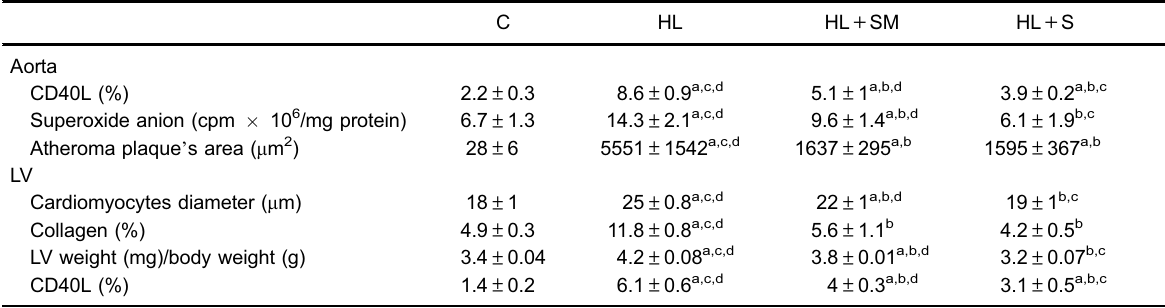
Figure 1. Representative photomicrographs of aortic section with immunohistochemical peroxidase staining to CD40L (A – D) and aortic atherosclerotic plaques (E – H). Representative photomicrographs of left ventricle sections showing cardiomyocytes diameter (I – L), collagen content (M – P) and immunohistochemical peroxidase staining to CD40L (Q – T). C: control group; HL: hyperlipidic diet-fed group; HL + SM: hyperlipidic diet-fed group treated with soy milk; HL + S: hyperlipidic diet-fed group treated with simvastatin. Table 2. Aorta and left ventricle (LV)